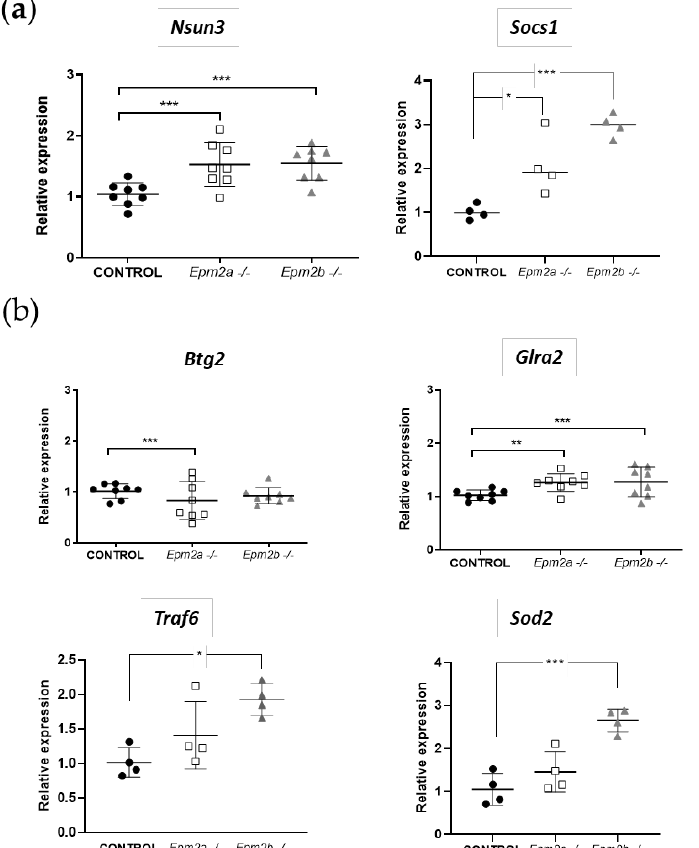
Figure 3. Expression of miR-146a/miR-155 putative target genes for miR-155 ( a ) and for miR-146a ( b ) in the brains of 16 mo mice. Total RNA was extracted from brain homogenates of 16 mo WT (CONTROL) and LD KO mice ( Epm2a − / − , Epm2b − / − ), and quantitative real-time PCR analyses were performed using the TaqMan™ probe system. The relative expression of putative target genes was determined using the comparative 2 − ∆∆ CT method with Gapdh gene as an internal reference. * p < 0.05, ** p < 0.01, *** p < 0.001, when compared to control mice via two-way ANOVA ( n = 4 or n = 8 when indicated).